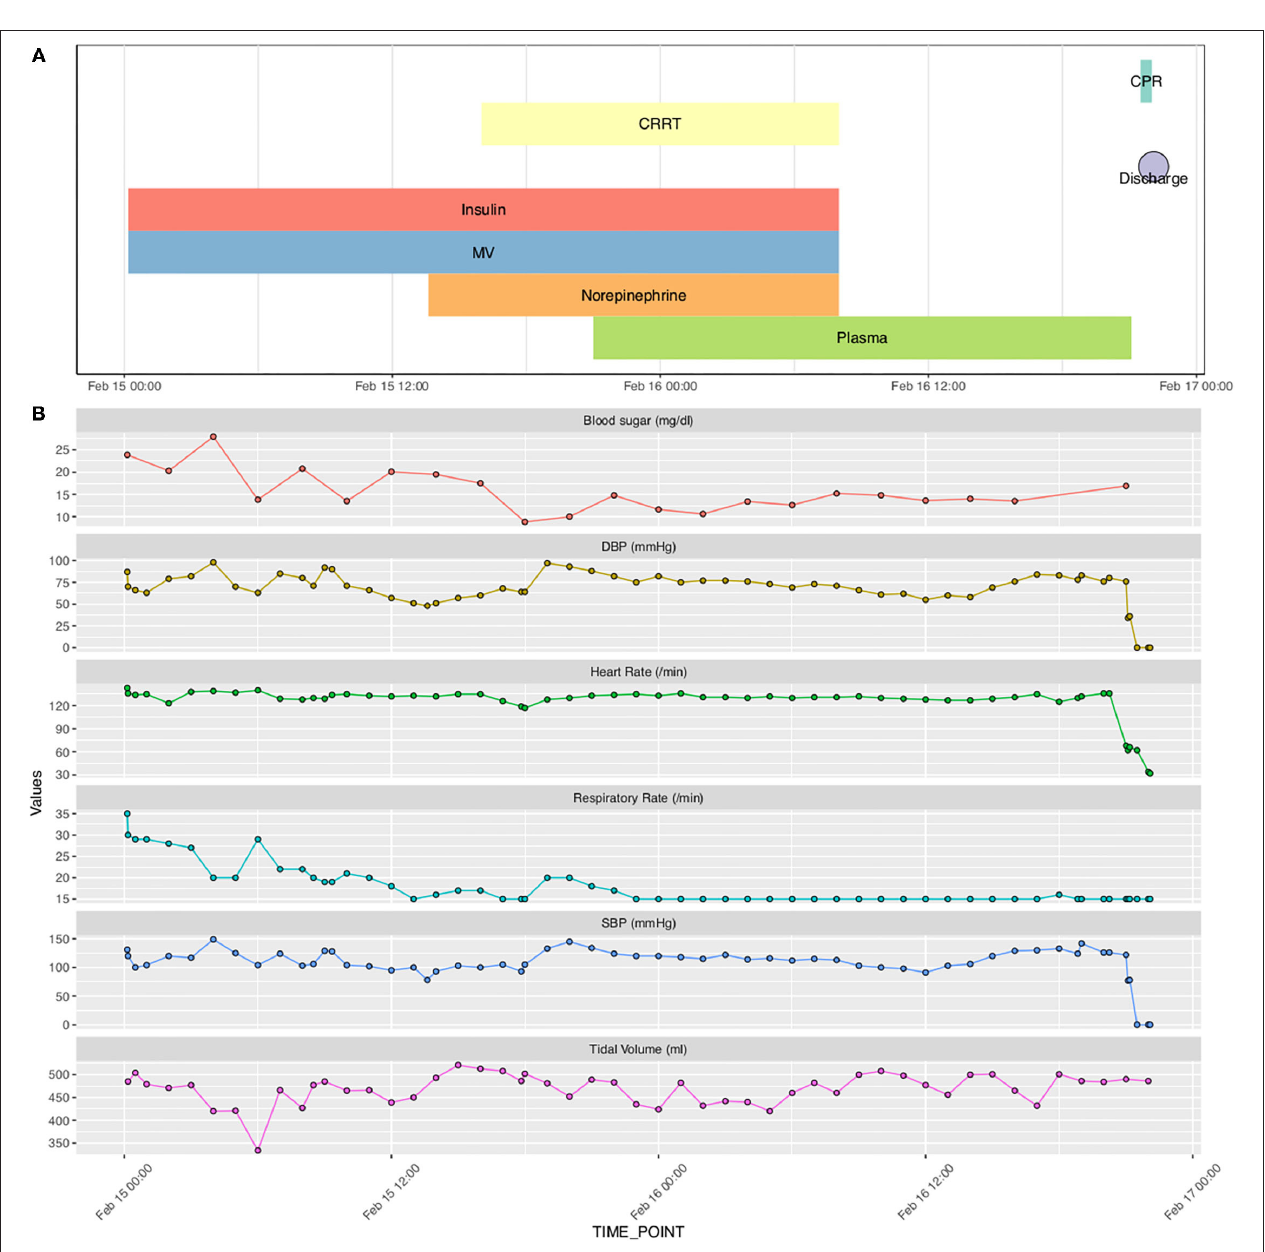
FIGURE 1 | Sample data for a single patient stay in the ICU. (A) Chart events extracted from free texts recorded in the nursing chart; (B) Structured numeric data extracted from the nursing chart. CRRT, continuous renal replacement therapy; MV, mechanical ventilation; CPR, cardiopulmonary resuscitation; SBP, systolic blood pressure; DBP, diastolic blood